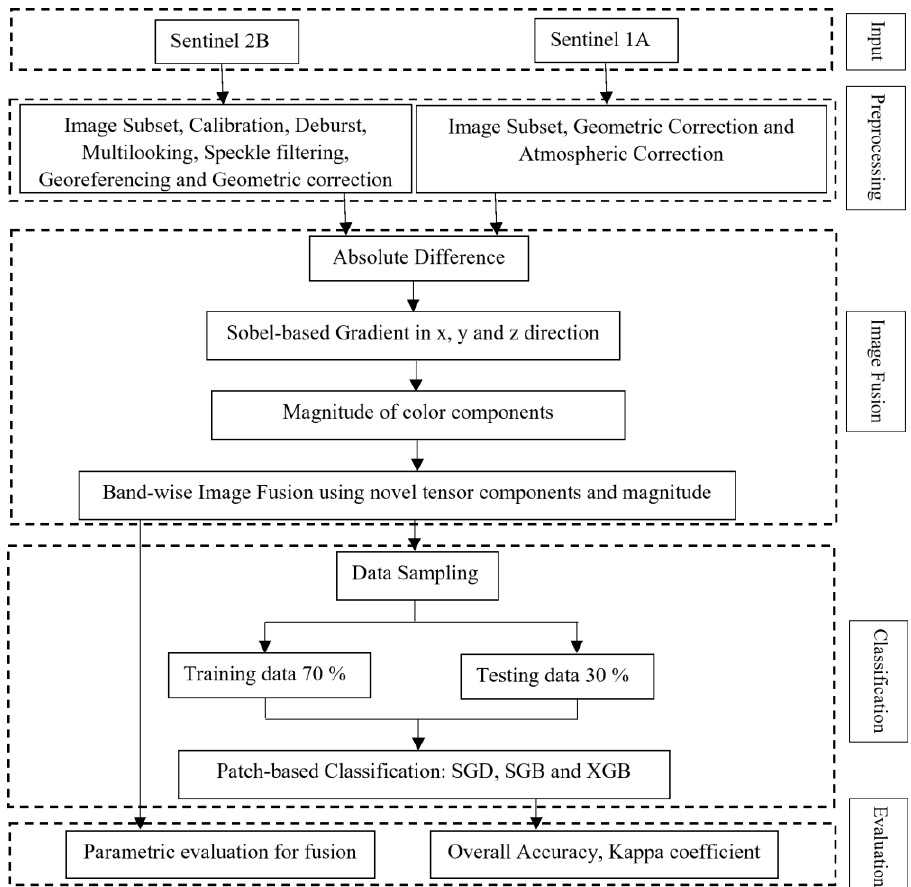
Figure 2. Methodology illustration to fuse and classify Sentinel 1A and Sentinel 2B dataset